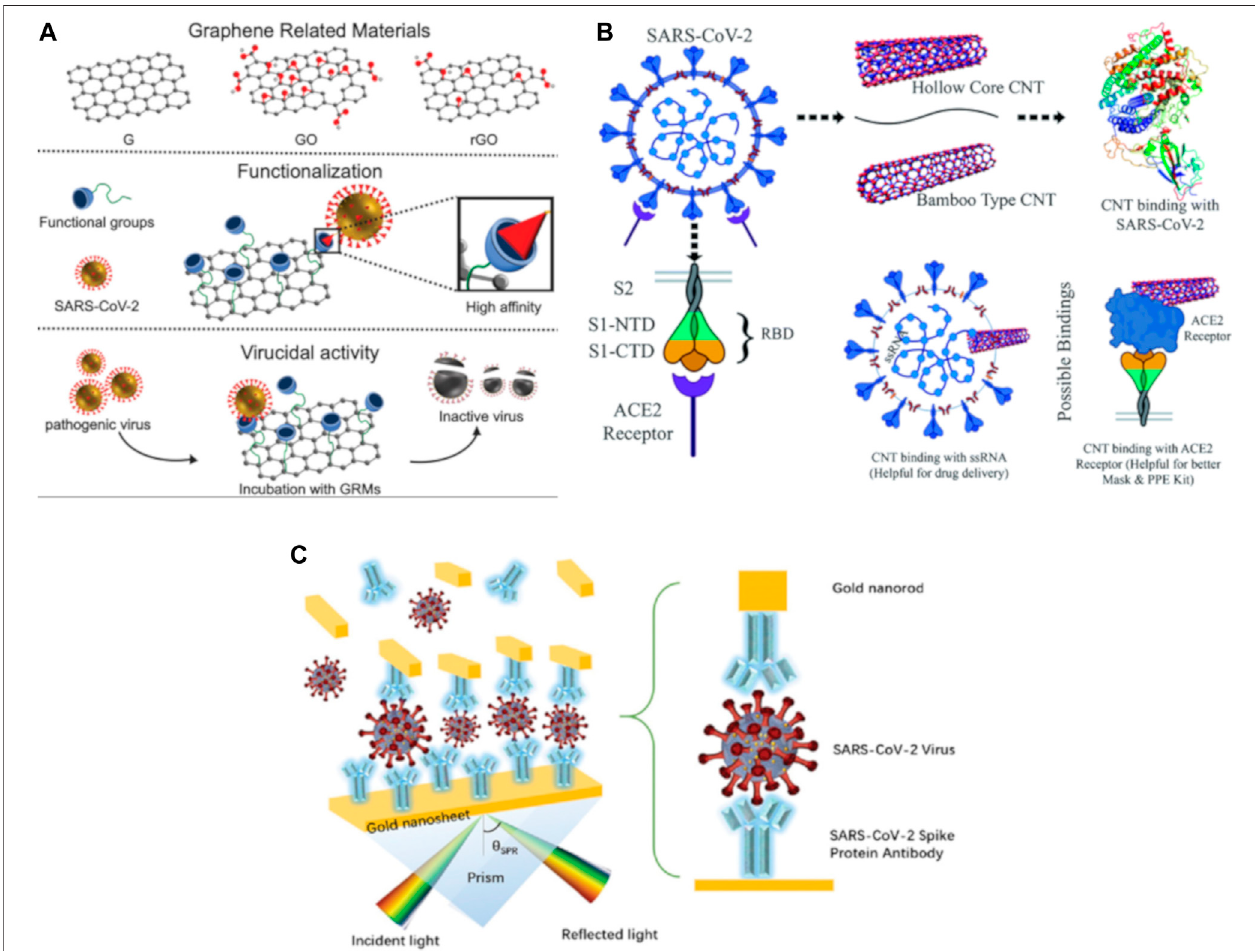
FIGURE 2 | An overview of the numerous possibilities for the use of graphene, carbon nanotubes and plasmonic nanosensors for COVID-19 sensing, diagnostics and treatment. (A) Graphene and its derivative materials (G, graphene; GO, graphene oxide; and rGO, reduced graphene oxide) can be used to selectively bind to the SARS-CoV-2 virus through chemical functionalization with speci fi c functional groups, and this can be harnessed to detect, capture and even neutralize the viral pathogen. Reprinted (adapted) with permission from (Reina et al., 2021). (B) Molecular docking simulations showing the binding interaction between multi-walled carbon nanotubes (CNTs) and targets of interest: the receptor-binding domain, ssRNA, or the ACE2 receptor corresponding to the SARS-CoV-2 virus. The binding af fi nity can be tuned depending on CNT tube structure, diameter, chirality, and other factors. Reprinted (adapted) from (Patel et al., 2021), CC BY 3.0 license. (C) Representative conceptual structure of a plasmonic immuno-assay based on a “ sandwich-type ” structure, demonstrating the concept of using gold nanorods to enhancethe electric fi eld, and tuning theangle ofre fl ection ofthe surfaceplasmon resonance. Reprinted (adapted) from(Daset al., 2020).CopyrightWiley-VCH GmbH. Reproduced with